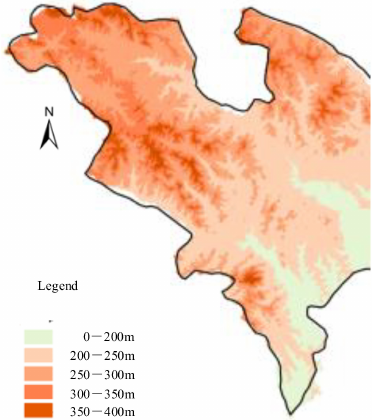
Figure 1. Spatial distribution map of soil erosion (M stands for